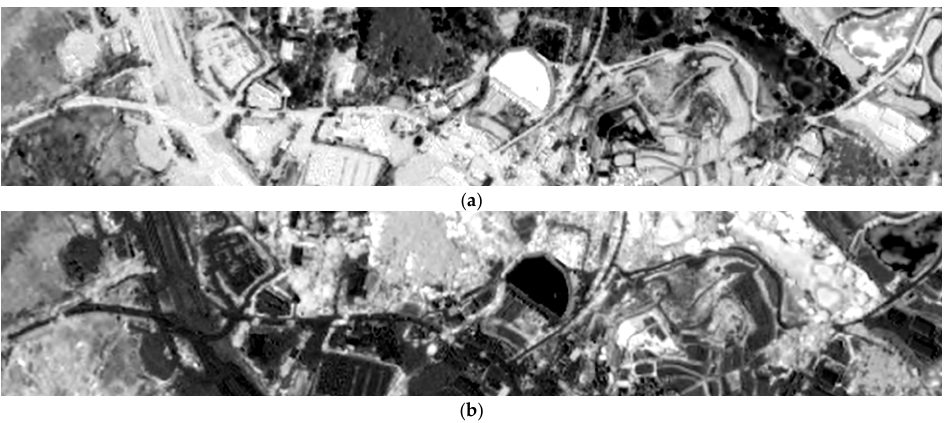
Figure 3. Examples of local injection gains based on NDVI values: ( a ) injection gains of the blue band determined using our algorithm; ( b ) injection gains of the NIR band determined using our algorithm.